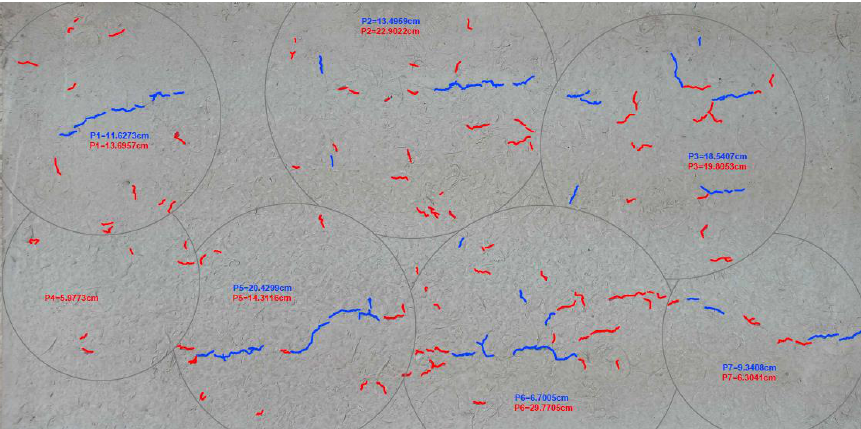
Figure 11. Distinguishing cracks on plates.